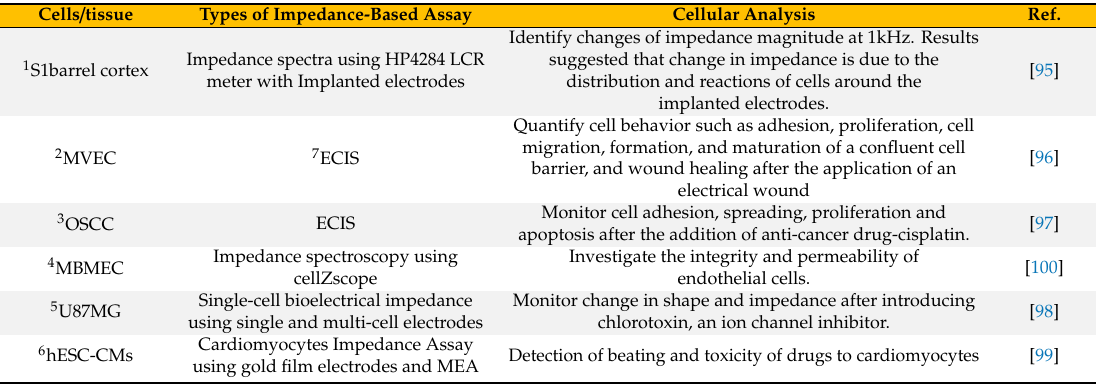
Table 2. Comparative use of impedance-based for cellular